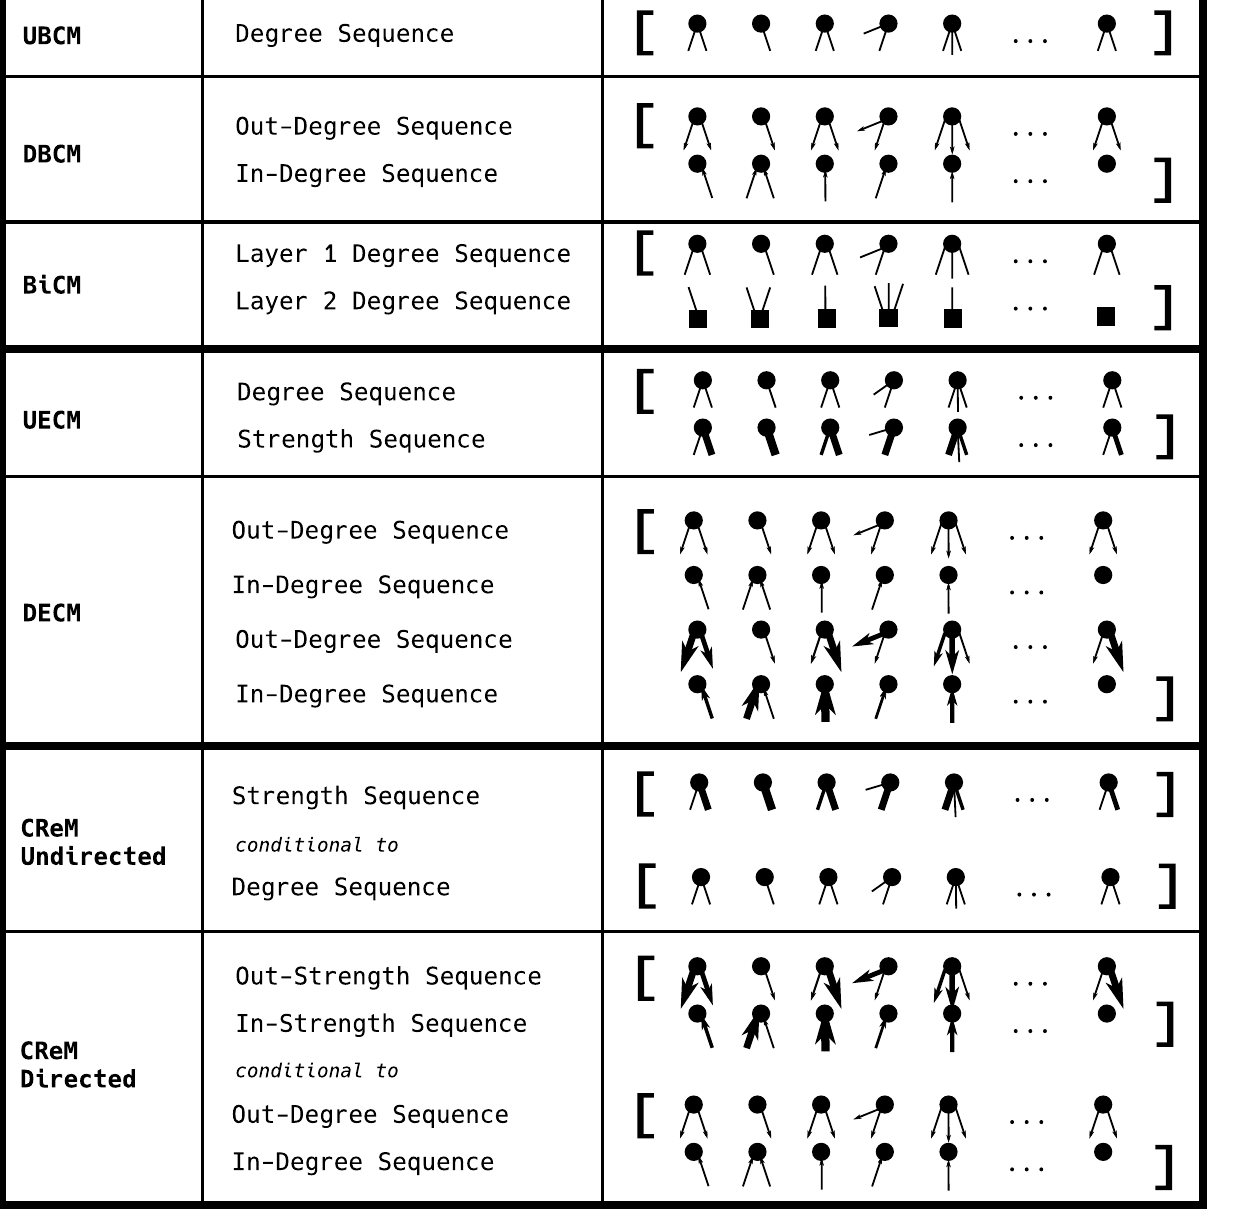
Figure 3. Graphical visualization of the constraints defining the ERGMs considered in this work. Notice that while the enhanced models (i.e. UECM and DECM) constrain binary and weighted quantities in a joint fashion, the conditional models (i.e. the CReM ones) allow for a ‘separate’ specification of